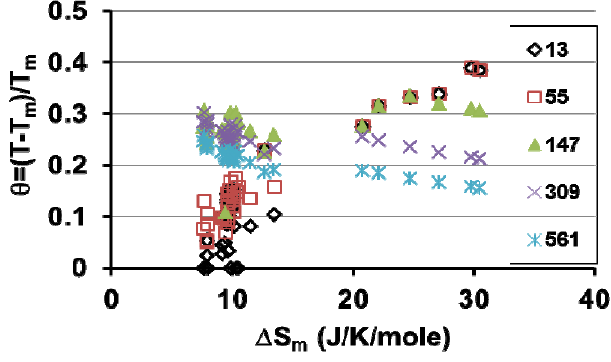
Figure 6. The melting temperatures of superclusters containing 13, 55, 147, 309 and 561 atoms. These melting temperatures are given in columns 10, 11, 12 and 13 of Table 3 versus Δ S